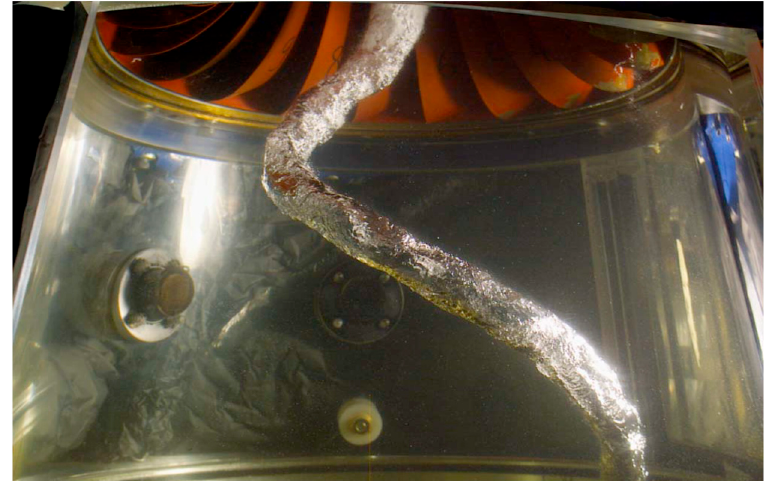
Figure 14. Vapor core rope development for σ = 0.380 [41].